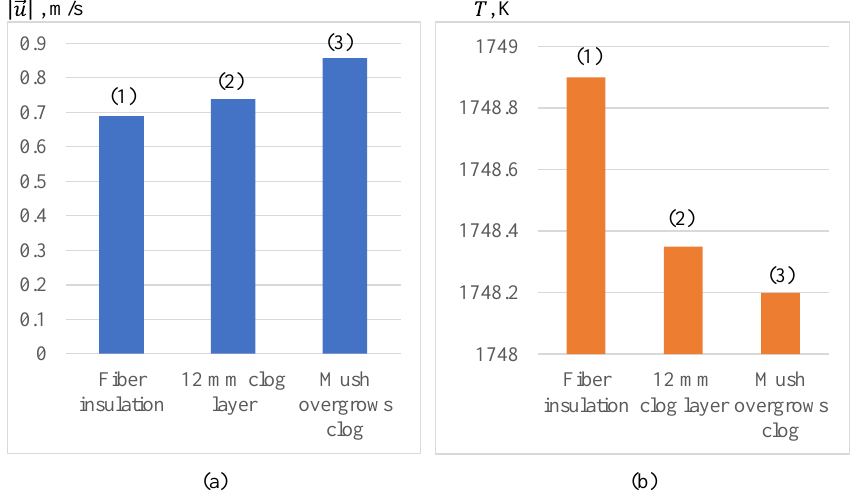
Figure 12. Sub-meniscus velocity ( a ) and the temperature change ( b ) at monitor point P1 marked in Figures 8 and 9 for the corresponding cases: ( 1 ) initial setup with the insulated SEN; ( 2 ) formation of the 12 mm clog layer; and ( 3 ) uninsulated SEN with the solidified layer overgrowing the clog (see Figure 7c).